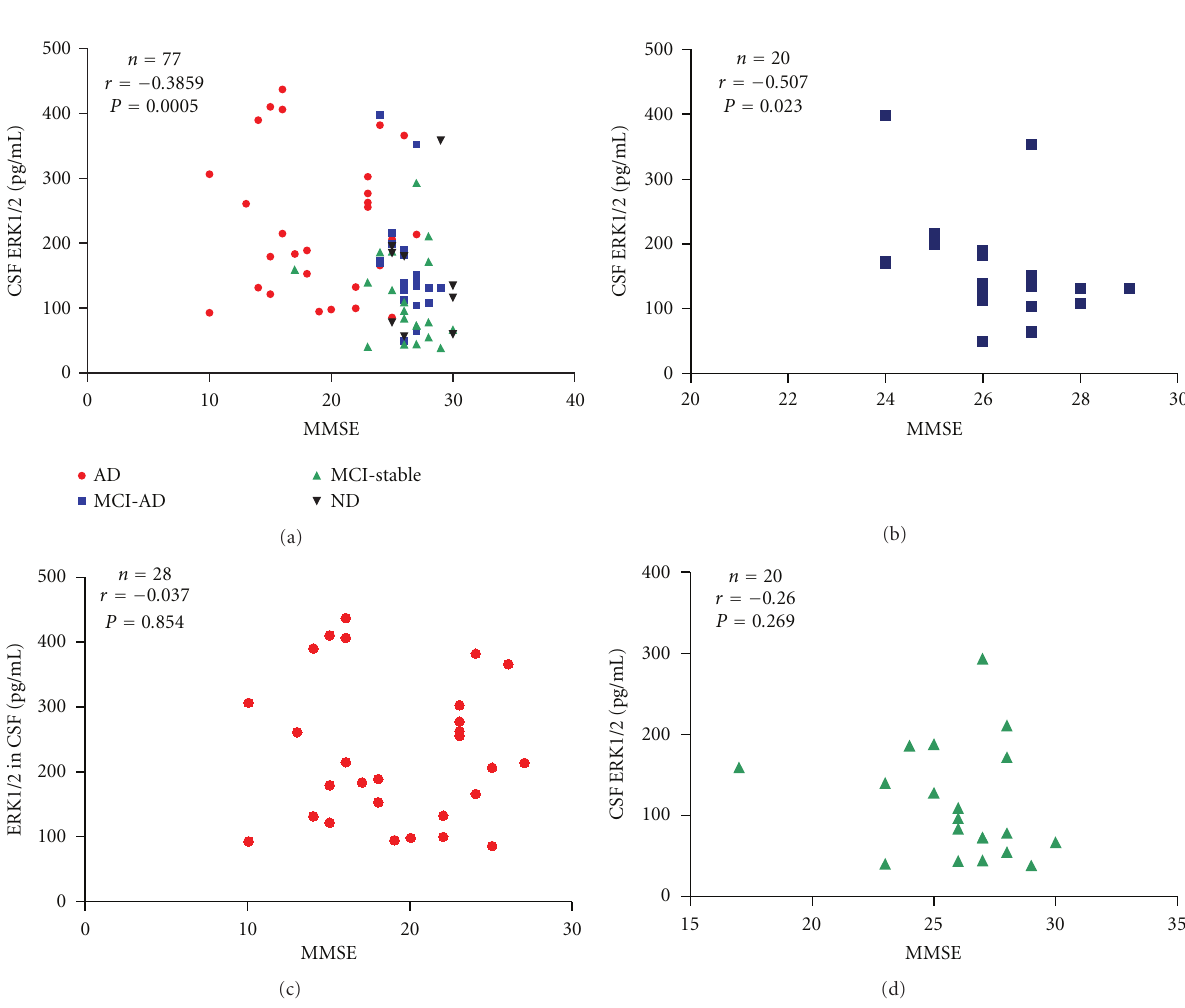
Figure 3: Scatterplots of MMSE scores plotted against CSF-ERK1/2 levels . (a) Whole sample ( n = 77). (b) MCI-AD group ( n = 20). (c) AD patients ( n = 28). (d) MCI-stable ( n = 20). The Spearman correlation coe ffi cients ( r ) and the two-tailed P values are indicated. Those samples with ERK1/2 measurements below LLOD were excluded from the